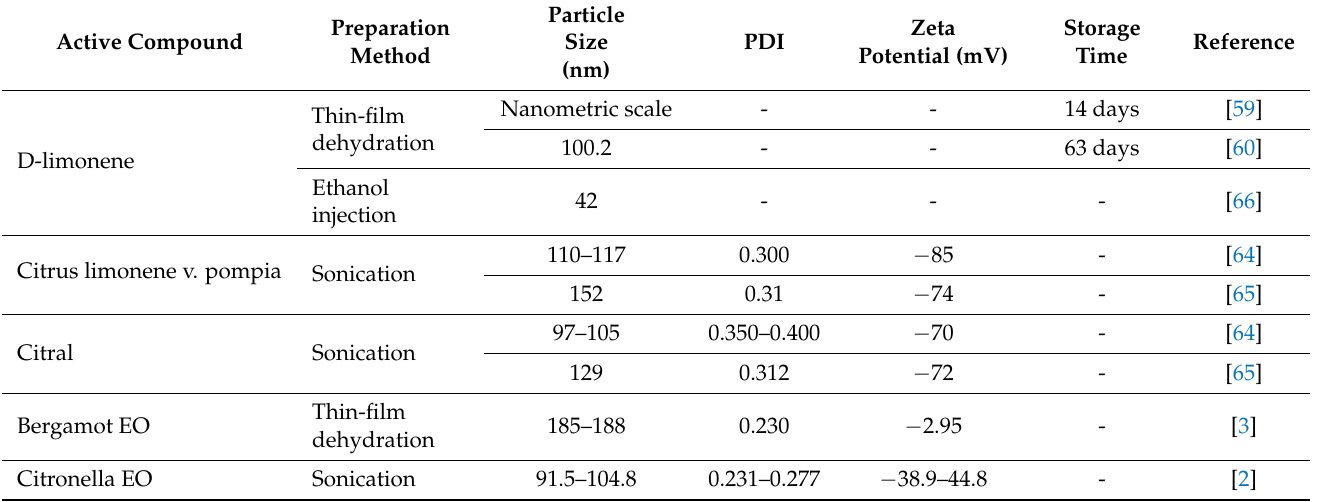
Table 2. Comparison of physical-chemical parameters of liposomal nanostructures loaded with different citrus EOs obtained thin-film dehydration and sonication